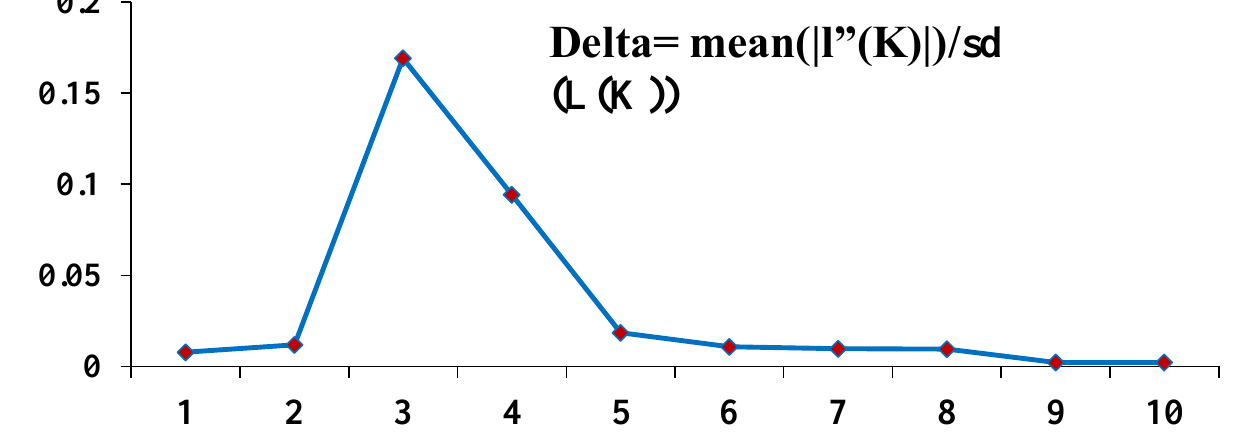
Figure 4. The Delta K values for the analysis STRUCTURE of Z. nummularia genotypes were calculated according to Evanno et al. (2000) and are plotted against the number of modeled gene pools (K).